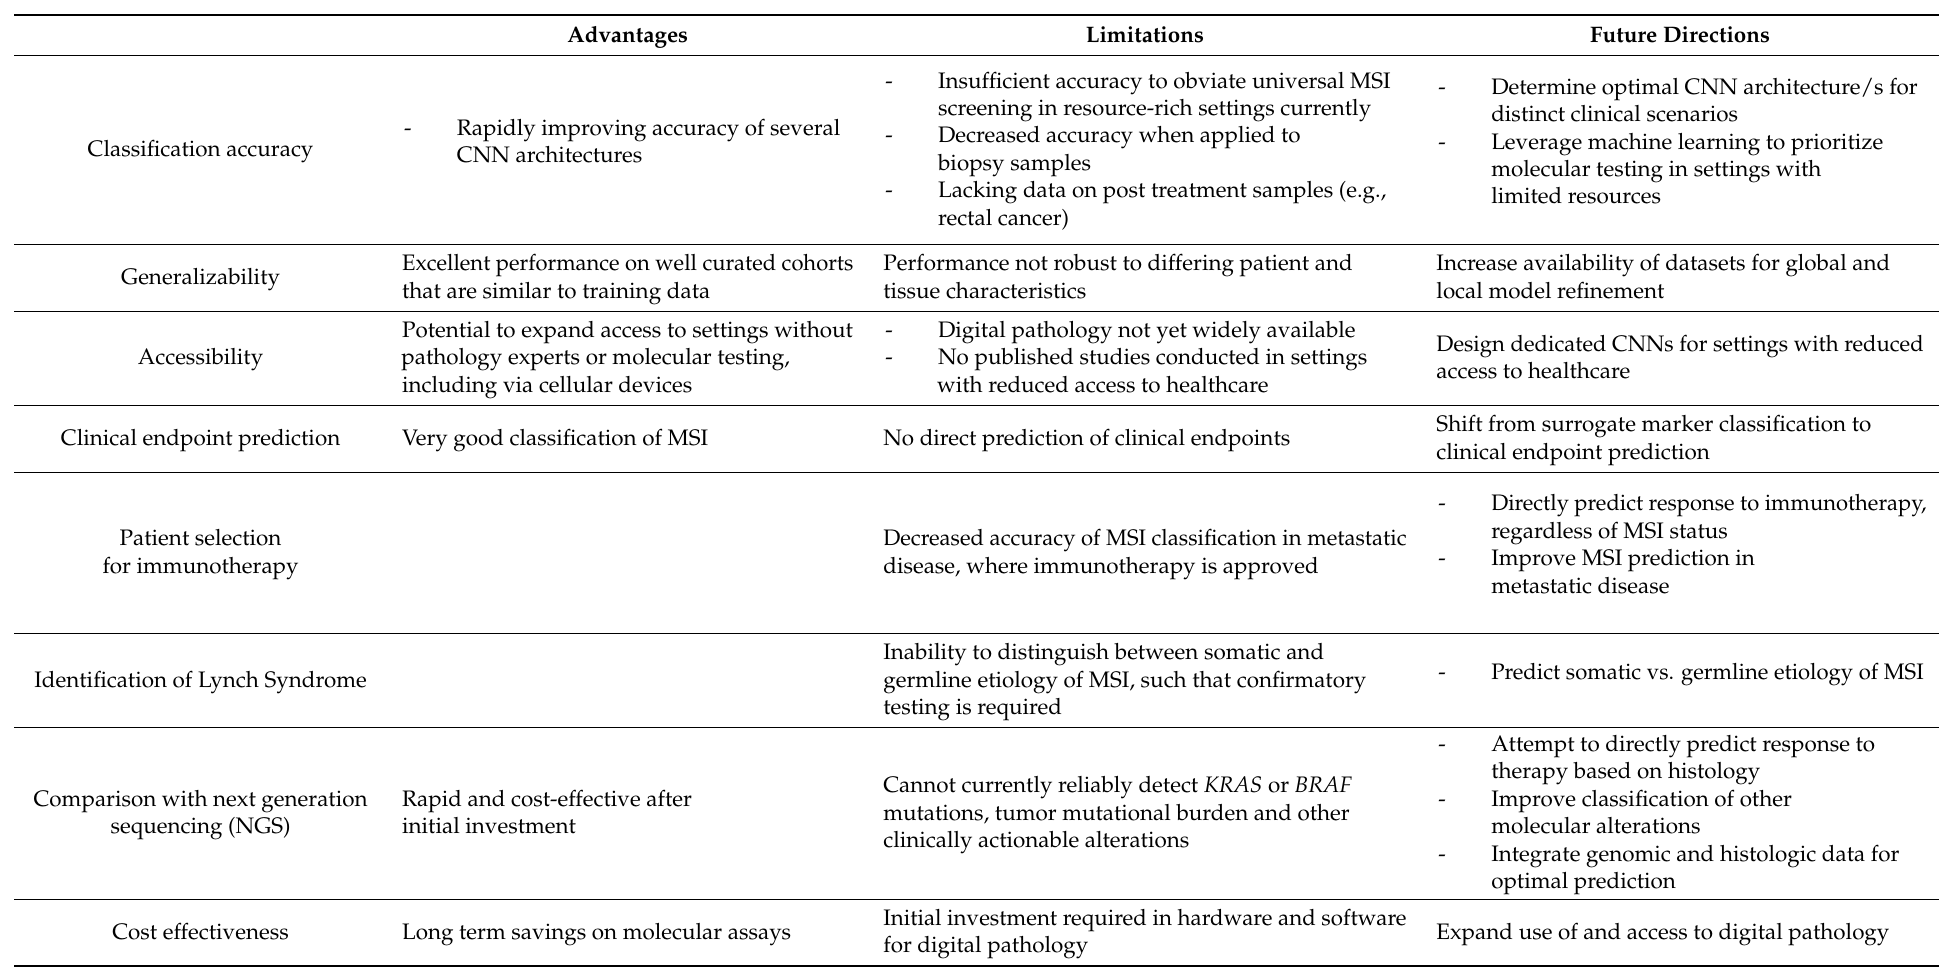
Table 3. Advantages, limitations, and future directions for MSI classification from digital pathology using machine